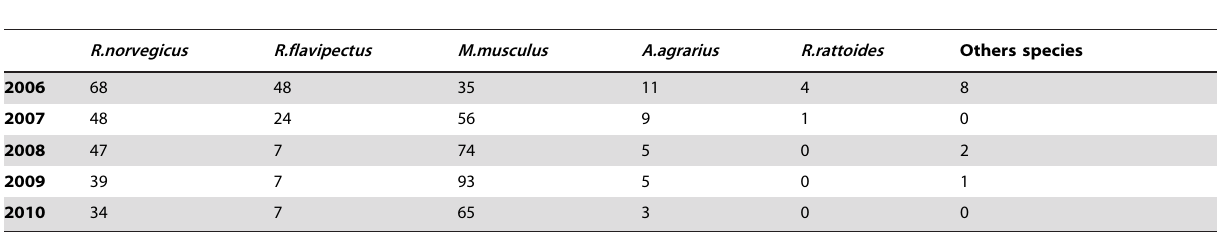
Table 2. The number of rodents of each species captured,